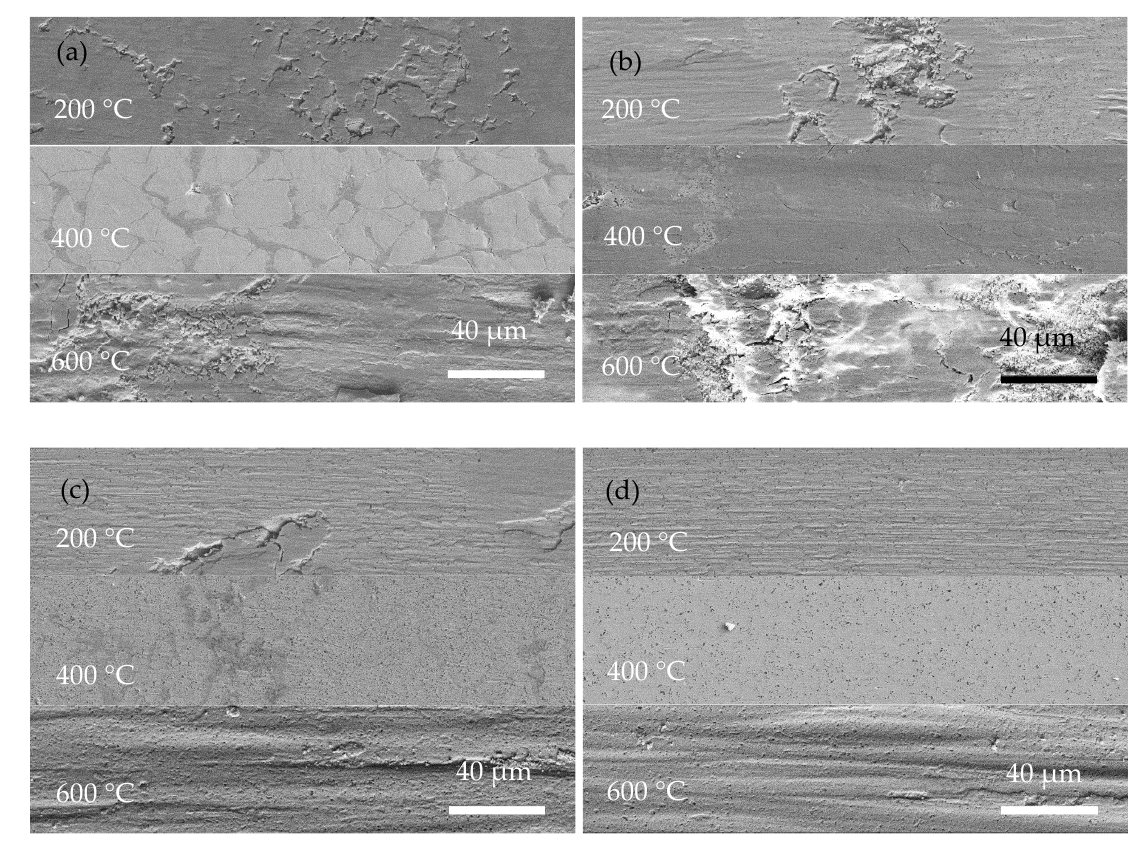
Figure 9. High-magnification surface morphologies of wear scar of coatings operated at 200 °C, 400 °C, and 600 °C: ( a ) Ni-P; ( b ) Ni-P-Si 3 N 4 -WS 2 , 0.5 g/L; ( c ) Ni-P-Si 3 N 4 -WS 2 , 1.5 g/L; ( d ) Ni-P-Si 3 N 4 -WS 2 , 2.5 g/L.